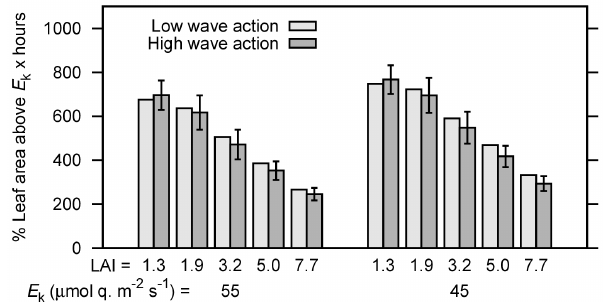
Figure 5. Time accumulated percentage of leaf area irradiated above photosynthetic saturation irradiance for low wave action and high wave action treatments, for E k of 45 and 55 m mol quanta m 2 2 s 2 1 . Error bars on high wave action treatment are the standard deviation over all 14 movement positions and hence indicate the range in the instantaneous canopy saturation